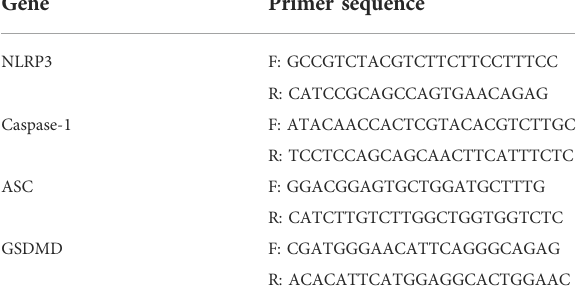
TABLE 1 The primer